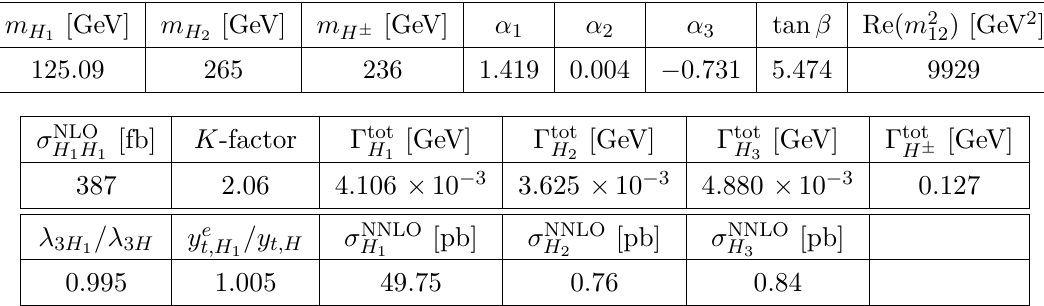
Table 10 . BP3 Upper: C2HDM-I input parameters. The third Higgs boson mass calculated from the input parameters is given by m = 267 GeV. Lower: additional double and single Higgs H 3 production related information. The value for y e is the CP-even part of the Yukawa coupling. t,H 1 The CP-odd part for the SM-like Higgs is